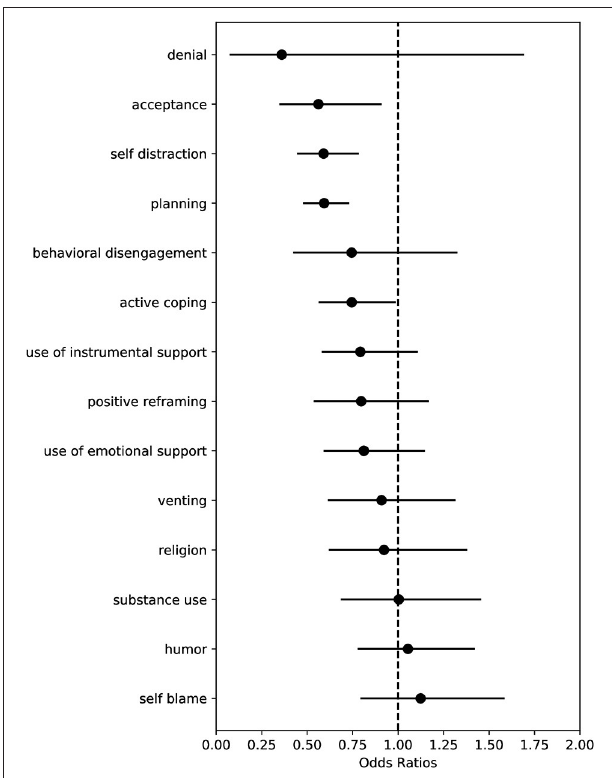
FIGURE 3 | Coefficients plot of COPE measures associated with event day deviation. Points indicate median effect size and black horizontal lines indicate the range of the 90% credible interval.